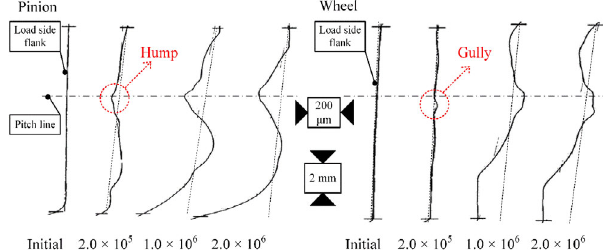
Fig. 6 Tooth profile deviation for the 13 N·m load under the dry running condition.